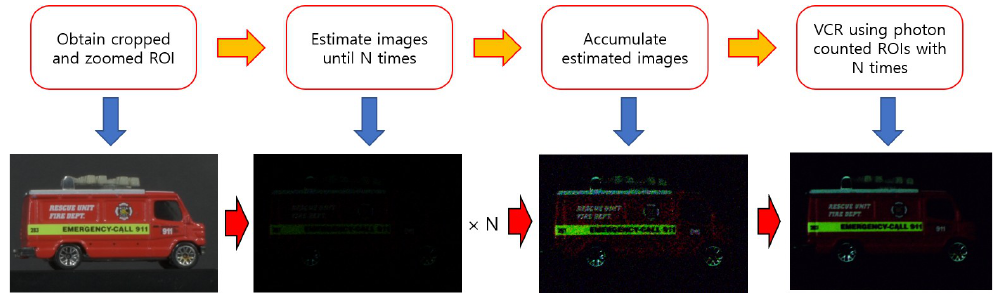
Figure 4. N observation photon counting imaging.